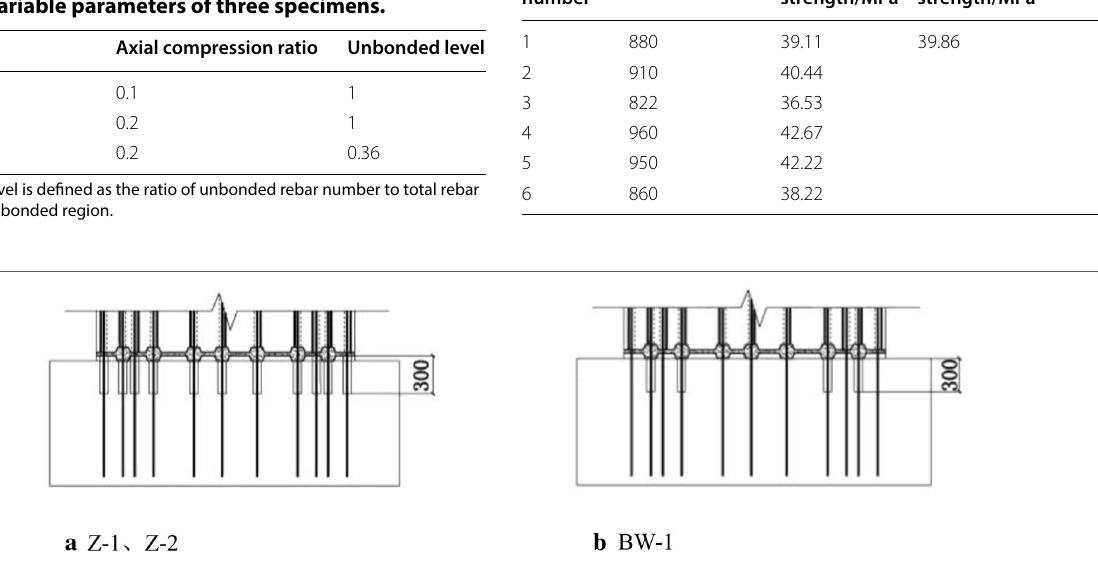
Fig. 3 Unbonded rebar distribution of three specimens in millimeters. For clarity, the horizontal rebars and stirrups in wall and base are not shown.